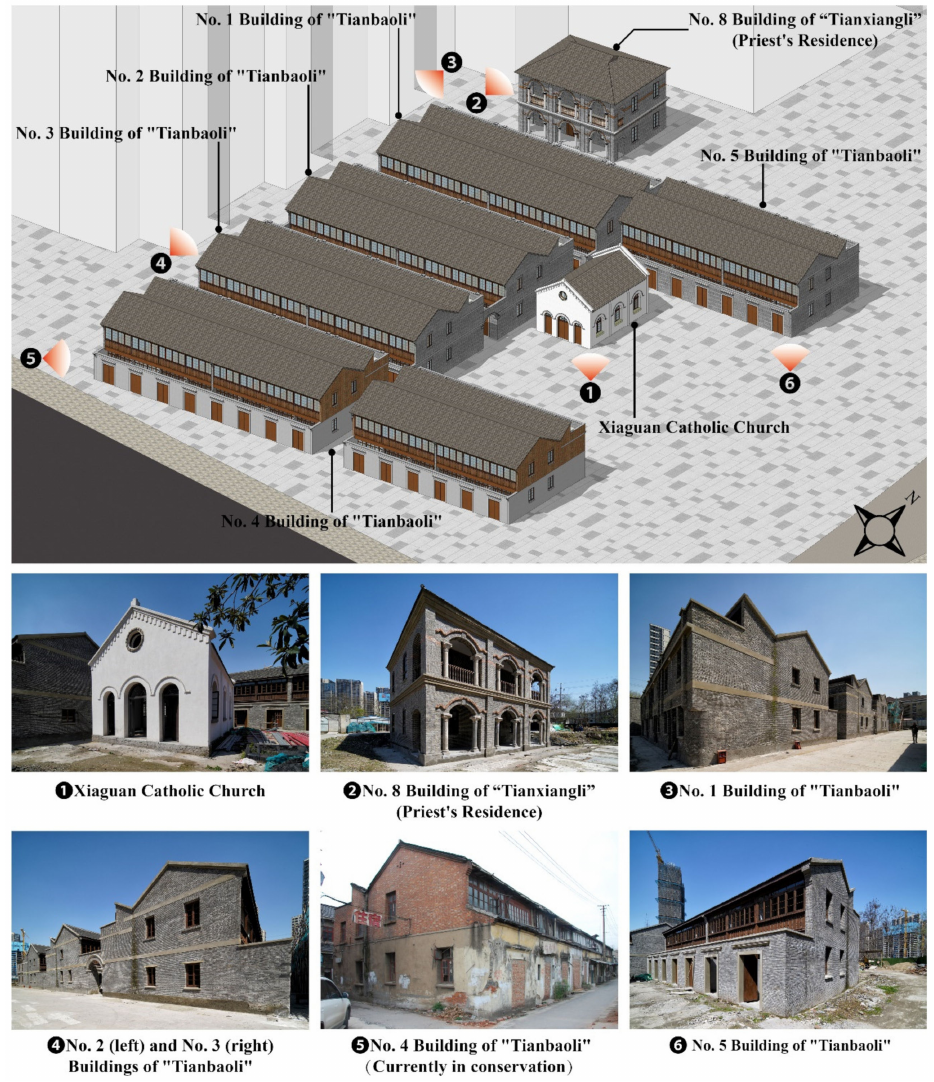
Figure 1. Composition of the “Tianzihao”